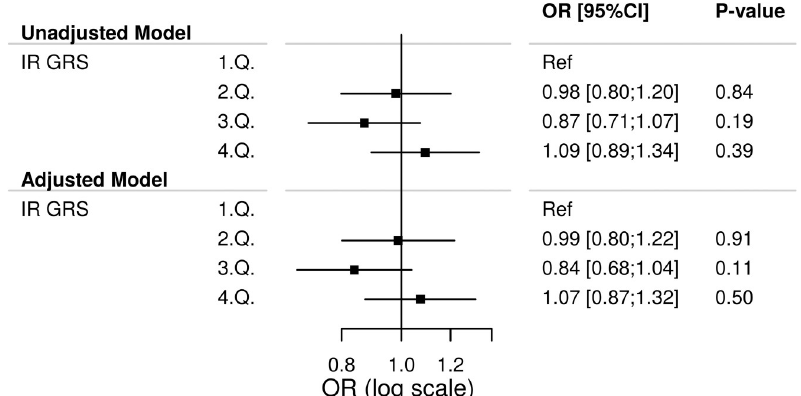
Fig 3. Association of the unweighted insulin resistance genetic risk score (IR GRS) with the risk of diabetes among 4963 patients referred for coronary angiography. Logistic regression was used for this analysis. 1.Q, ... ,4.Q: 1. Quartile, ... ,4. Quartile. Ref: Reference. The Adjusted Model was adjusted for gender, age, smoking status and